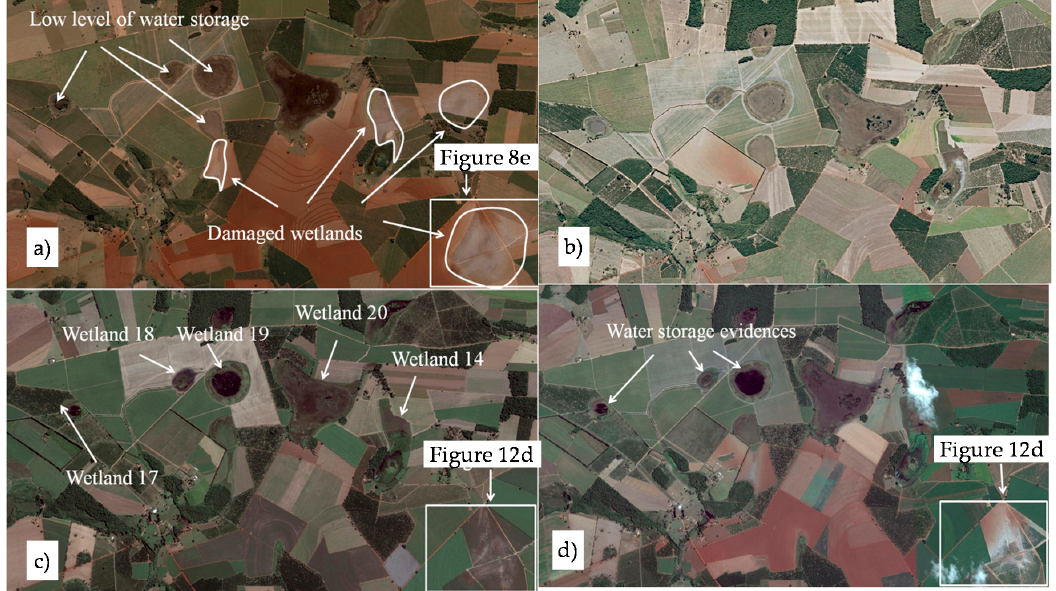
Figure 7. Water variations in the wetlands during different seasons: ( a ) August 2004—dry period; ( b ) July 2011—dry period; ( c ) May 2016—final rainy period; ( d ) February 2017—rainy period.